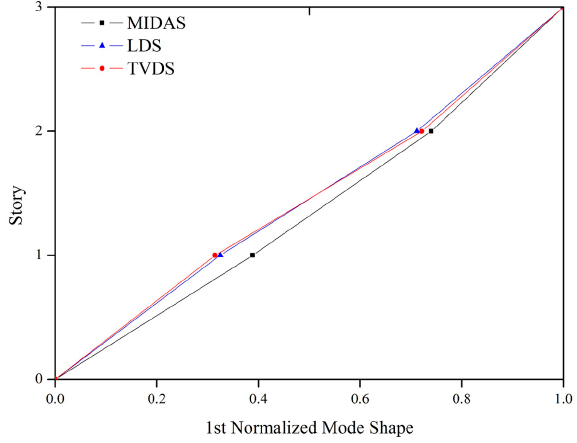
Figure 12. Comparison of the analytical and experimental mode shapes of the scaled model.